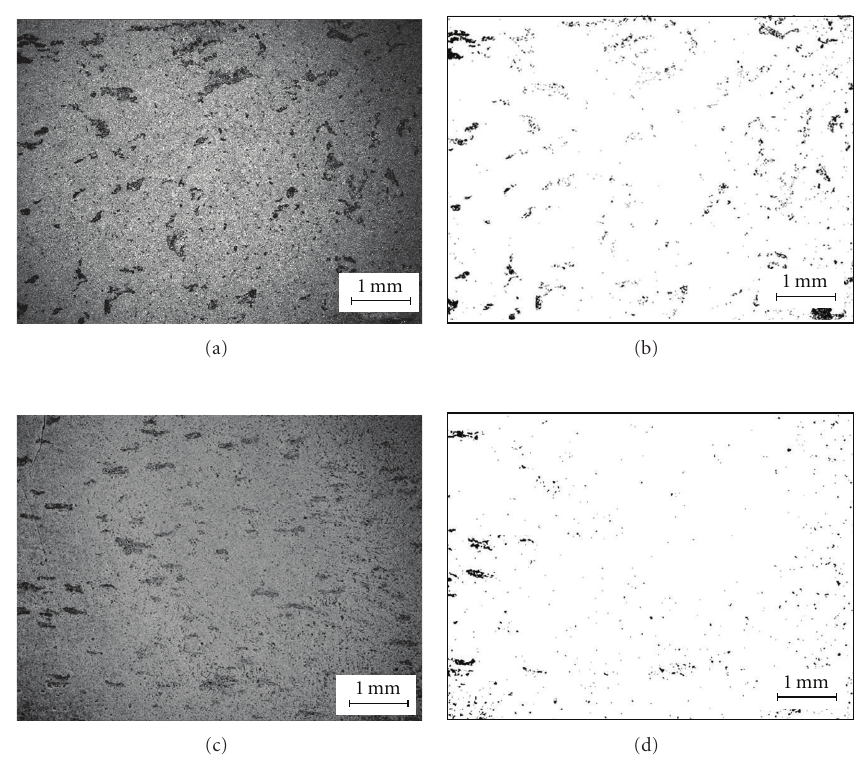
Figure 12: OM photographs of samples of TiC-TiB 2 -Ni(52.5/17.5/30), (a) without preheating and (c) with preheating at 400 ◦ C for 24 h, respectively. The monochrome images of (a) and (c) are shown in (b) and (d), respectively, in which the black area approximately reflects the pores by image process using Canvas software.